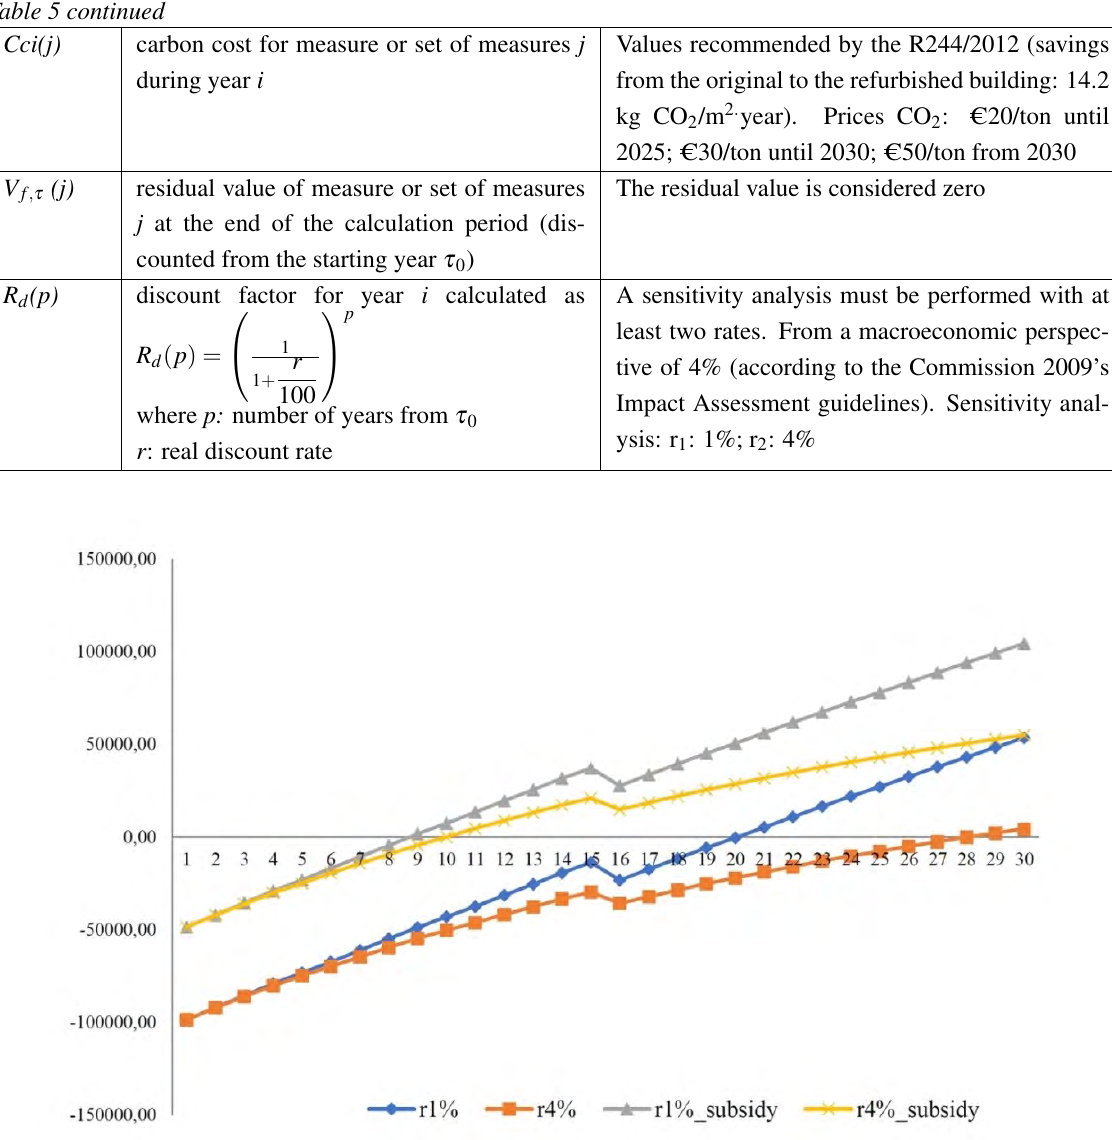
Figure 14. Fac¸ade, sloping roof and flat roof refurbishment